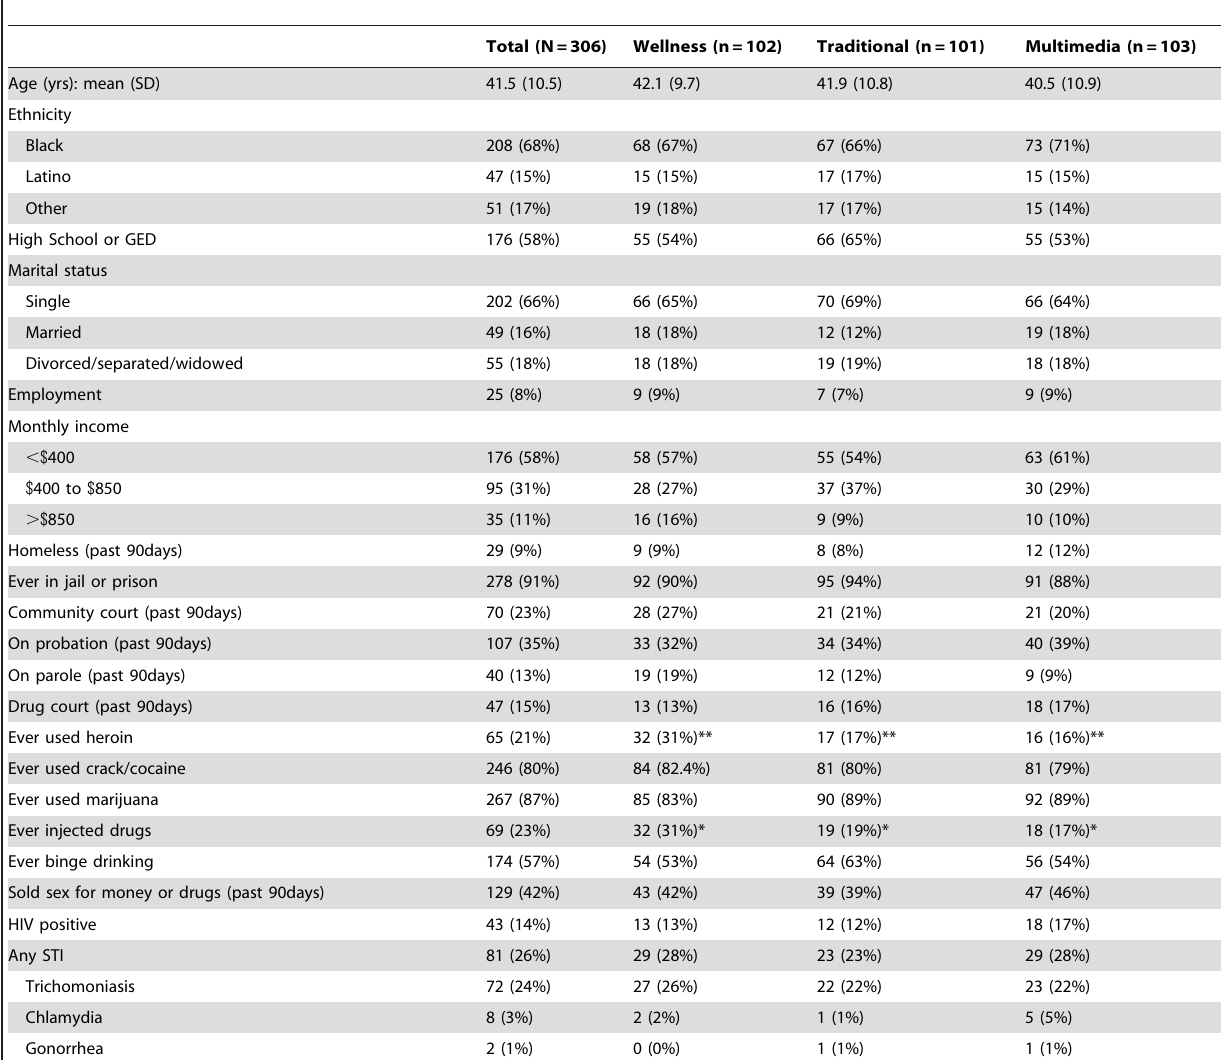
Table 1. Socio-demographics, Criminal Justice Involvement, History of Drug Use, and Bio-testing at the Baseline Assessment: All Participants and by Intervention